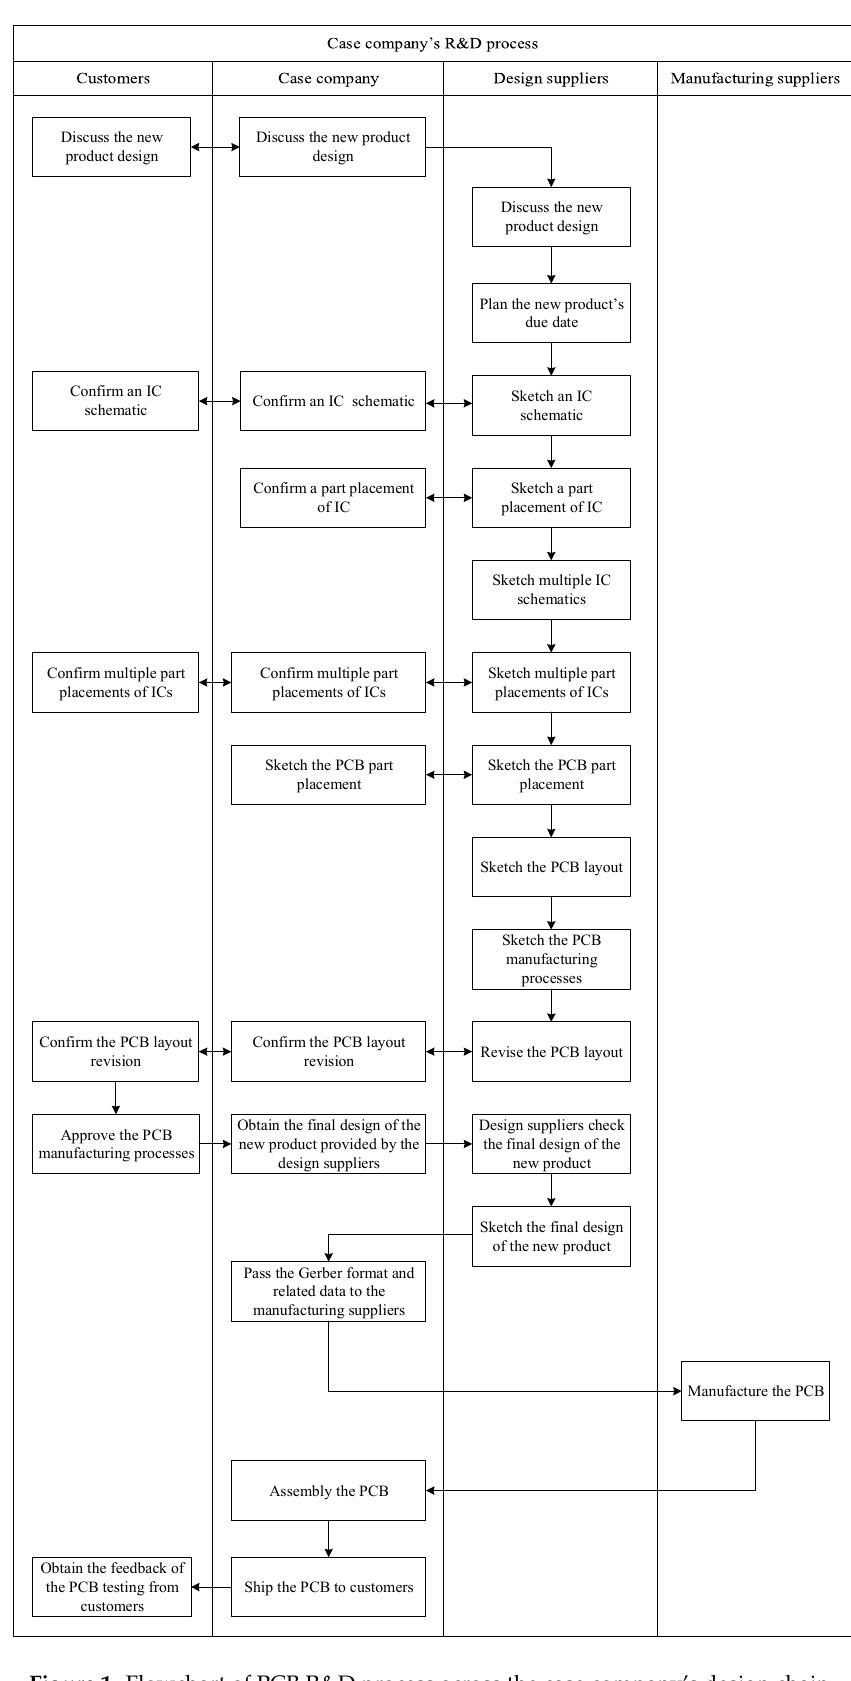
Figure 1. Flowchart of PCB R&D process across the case company’s design chain.